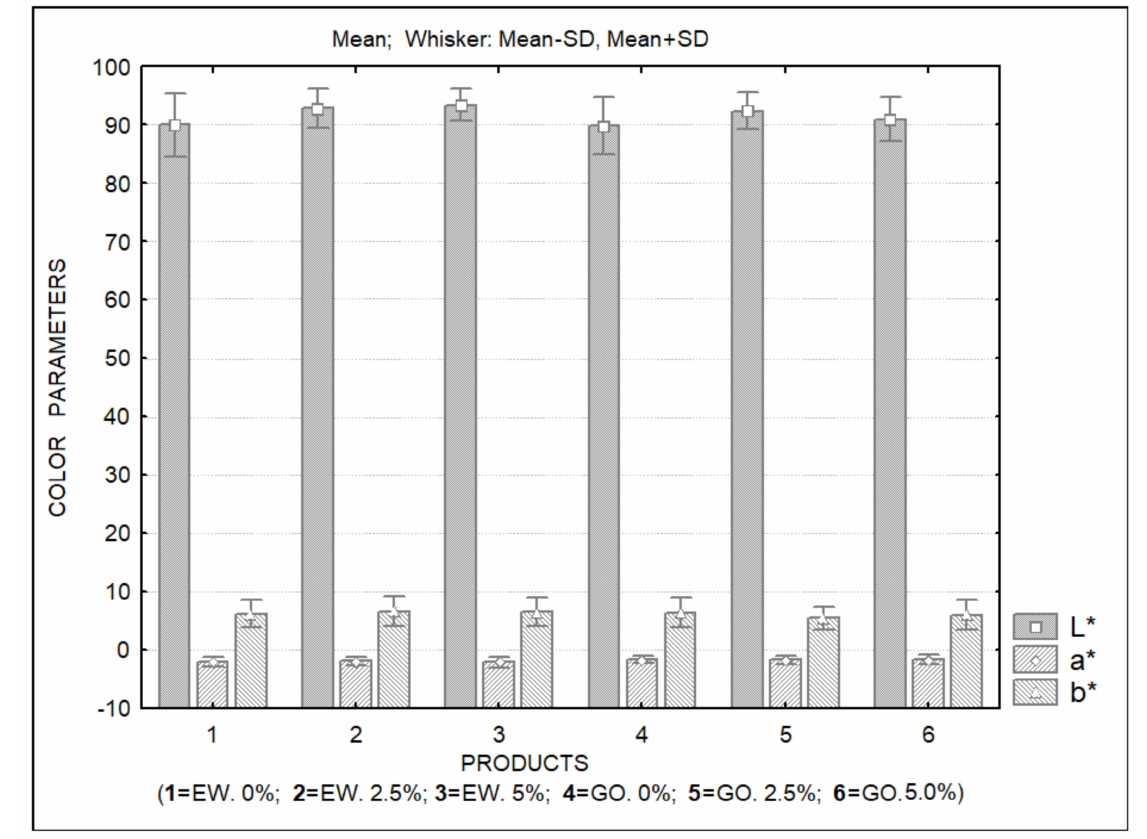
Figure 6. CIEL*a*b* color parameters of ewe’s and goat’s frozen yoghurts produced with UF concentrated cheese whey over 21 days of refrigerated storage (EW. 0% = ewe’s yoghurt with 0% inulin addition; EW. 2.5% = ewe’s yoghurt with 2.5% inulin addition; EW. 5.0% = ewe’s yoghurt with 0% inulin addition; GO. 0% = goat’s yoghurt with 0% inulin addition; GO. 2.5% = goat’s yoghurt with 2.5% inulin addition; GO. 5% = goat’s yoghurt with 5% inulin addition). Different letters indicate significant differences ( p < 0.05) between frozen yoghurts. Table 4. Matrix of color differences ( ∆ Eab*) between frozen yoghurt